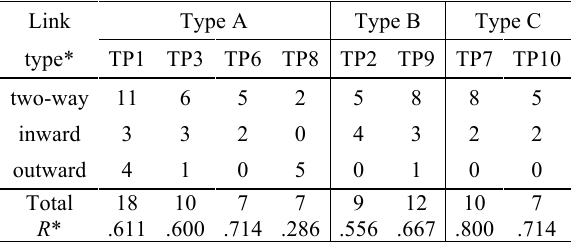
Note. R* denotes the reciprocity defined as the ratio of the number of two-way links to the total number of links, e.g., .611 = 11/(11 + 3 + 4).